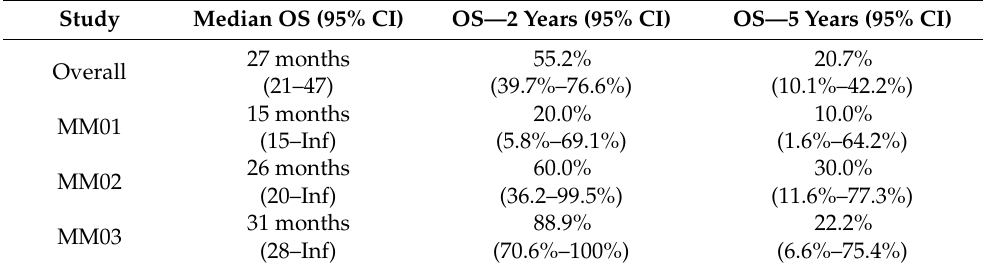
Table 2. Overall survival analysis based on the Kaplan–Meier curve.